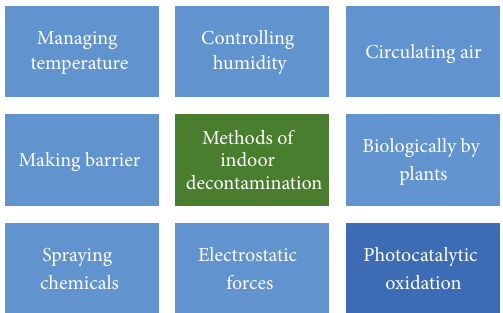
Figure 2: Methods of indoor